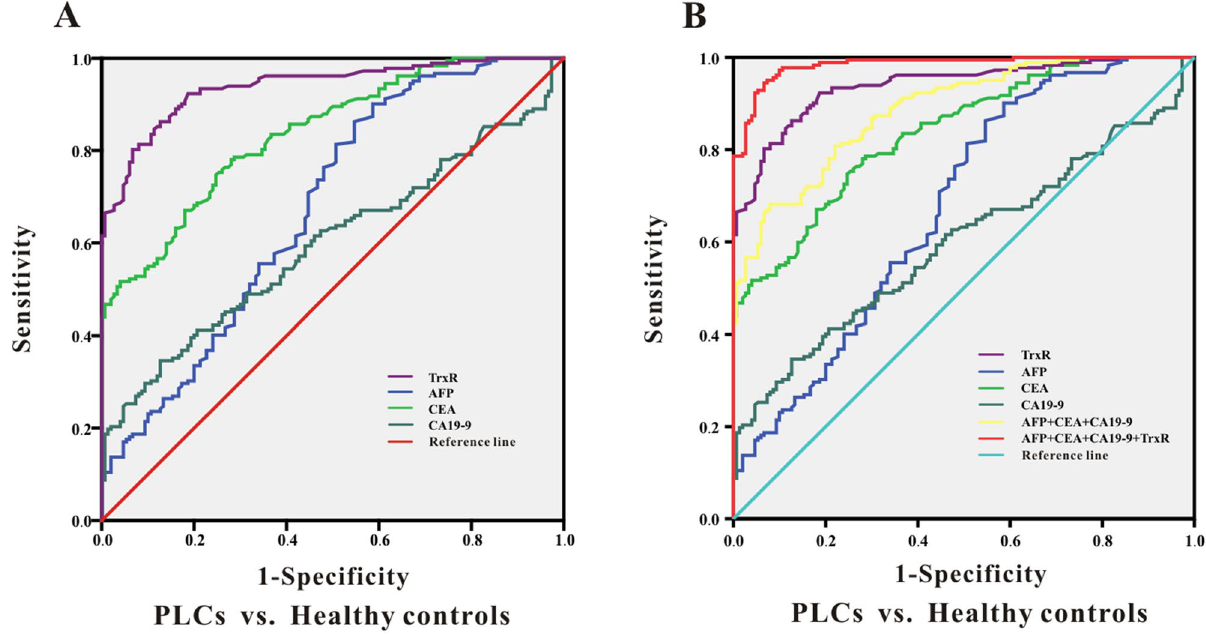
Figure 2. ROC curve analyses of TrxR, AFP, CEA, CA19-9 ( A ), and the combinations ( B ) for the differentiation of PLCs and healthy controls.